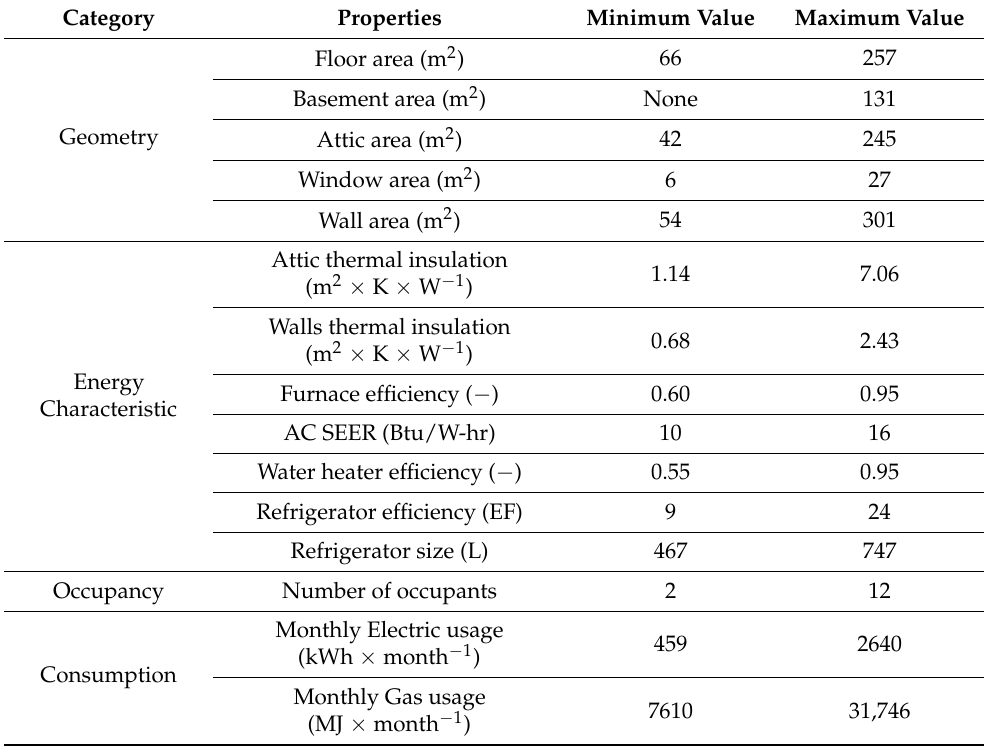
Table 2. Ranges of residential building geometrical data, energy characteristics, and residence occupancy collected during a summer 2015 audit of 101